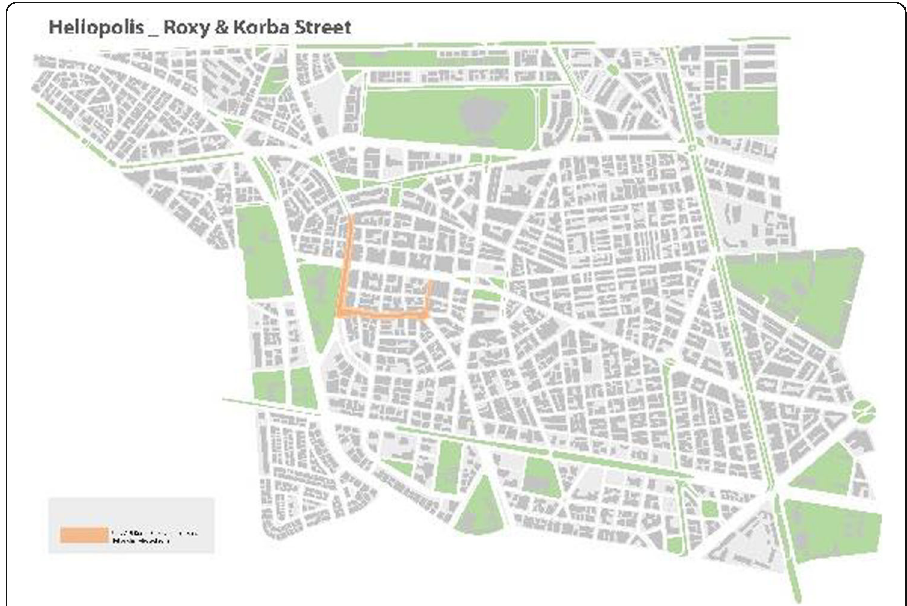
Fig. 3 Heliopolis map, Korba and Roxy Streets as public space